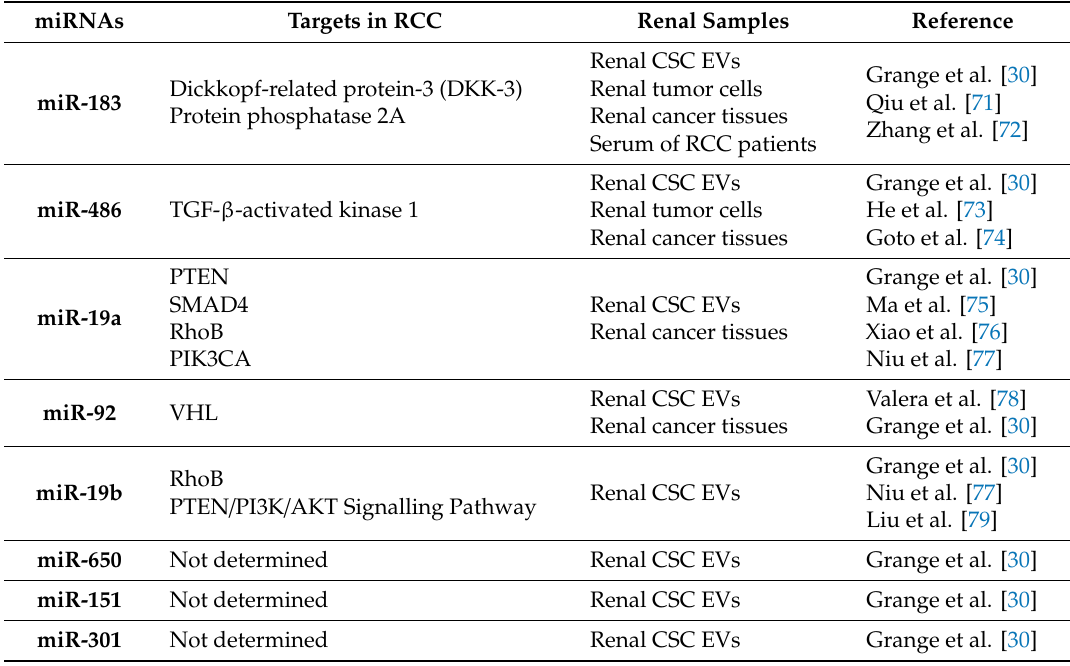
Table 1. OncomiRNAs carried by renal CSC EVs. The table lists some of the oncomiRNAs carried by renal CSC EVs and highlights their targets in renal cell carcinoma and the renal samples used to identify specific